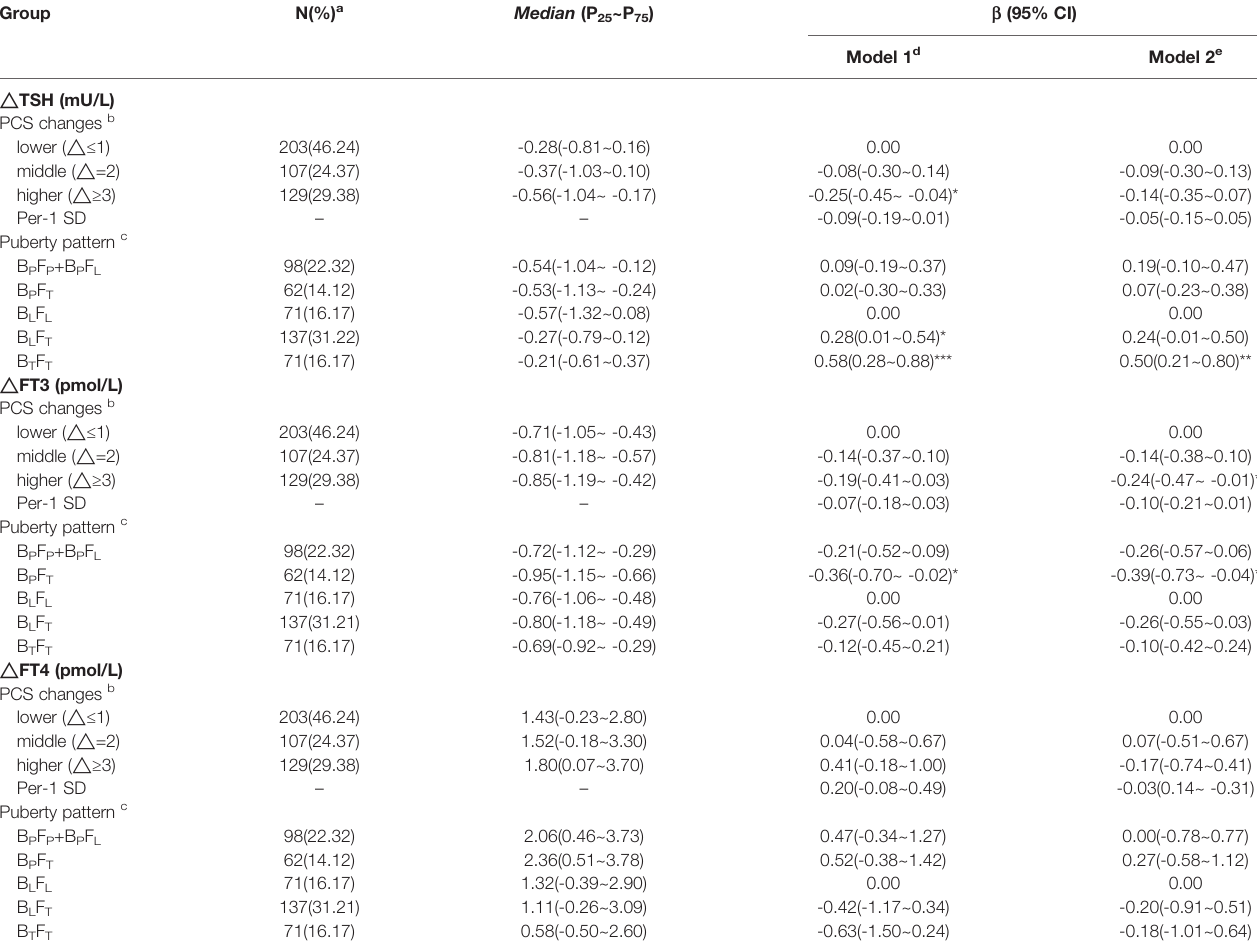
TABLE 3 | b and 95% con fi dence interval (95% CI) for thyroid hormones changes ( △ THs) according to puberty development by multiple liner regression